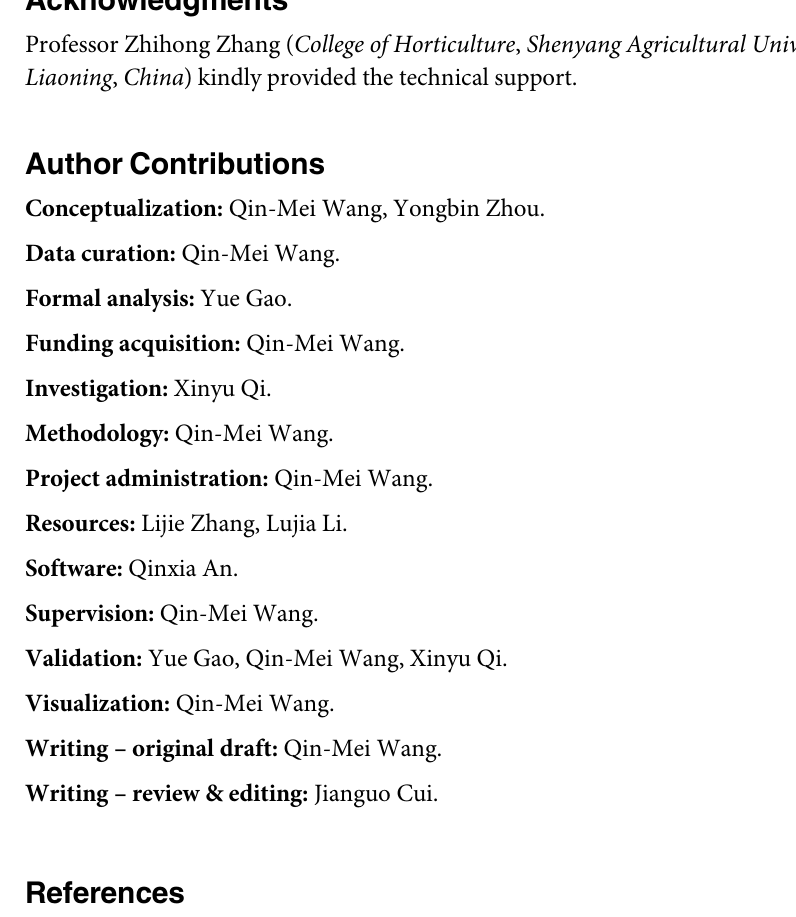
S2 Table. Changes in cytosine methylation pattern in ex vitro plants compared with the corresponding in vitro plants of L . ruthenicum